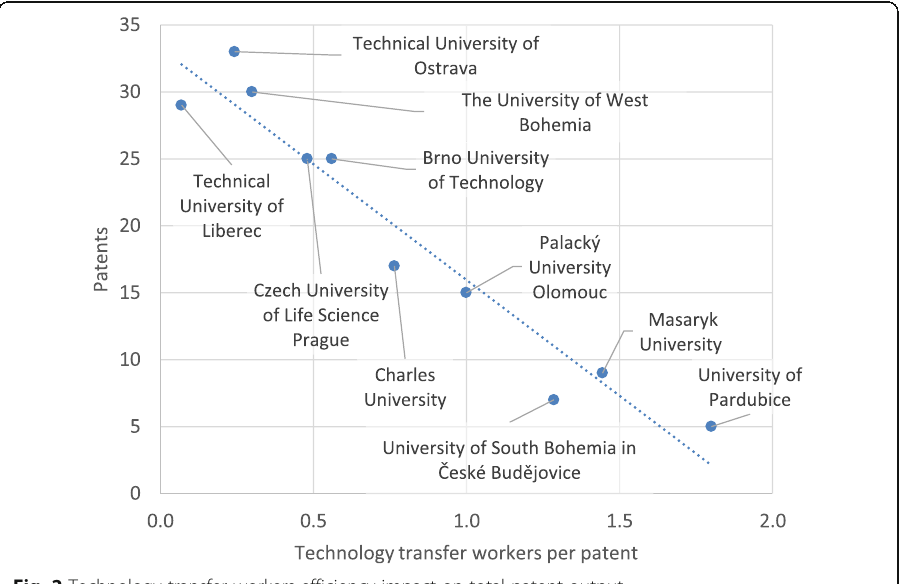
Fig. 2 Technology transfer workers efficiency impact on total patent